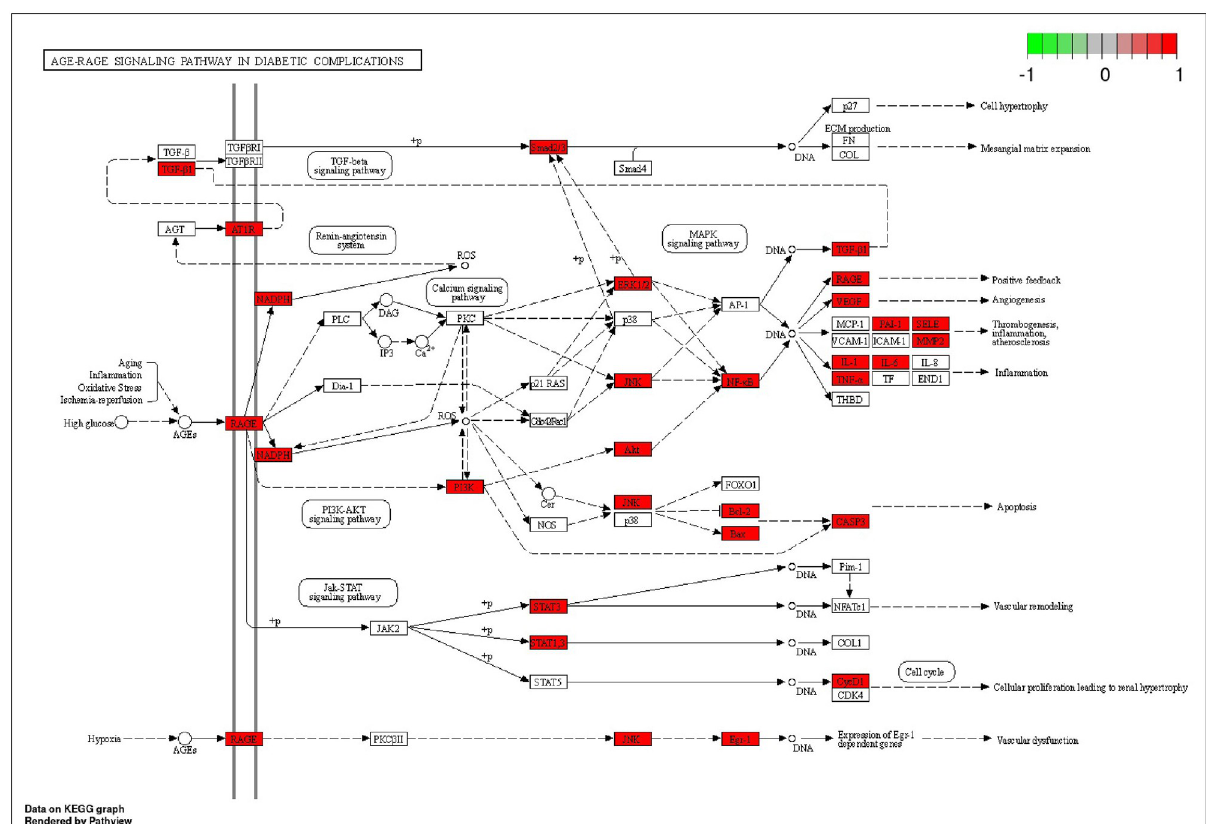
Fig 4. AGE-RAGE signaling pathway in diabetic